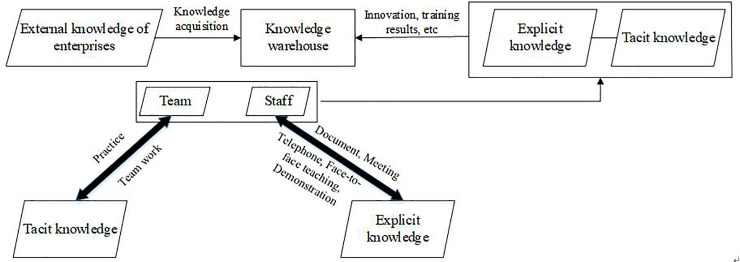
Enterprise knowledge flow model.